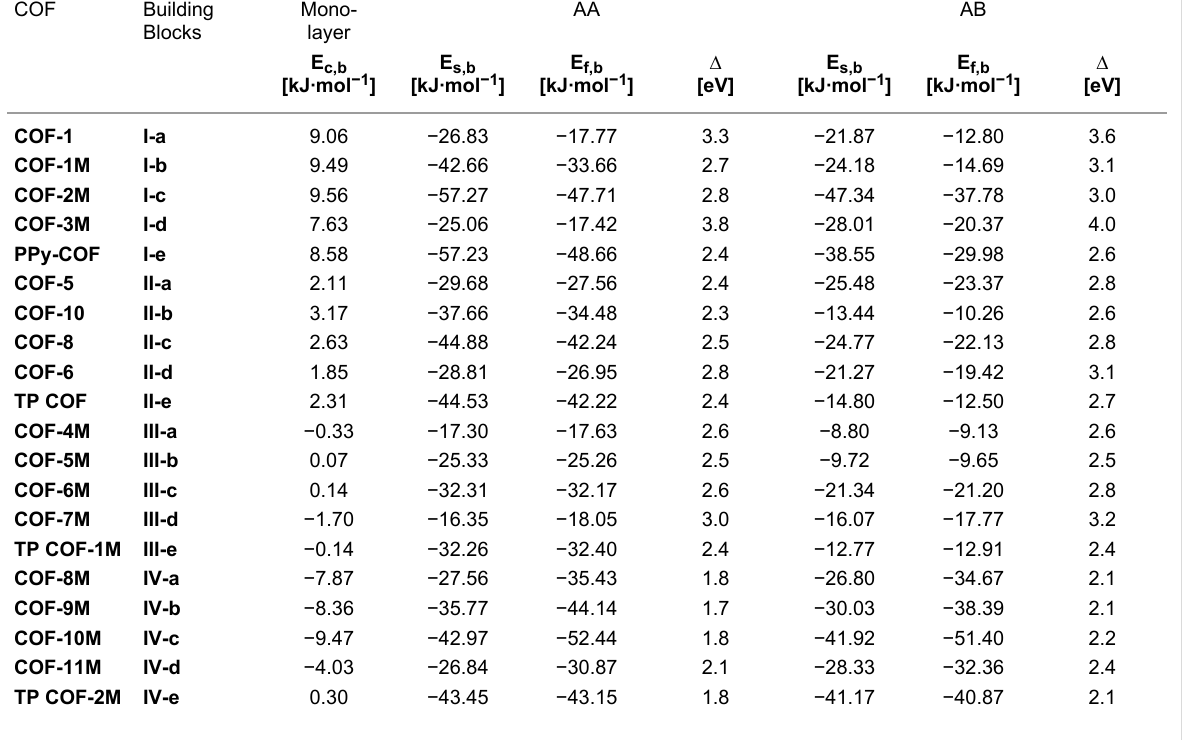
Table 2: The calculated energies [kJ•mol − 1 ] per bond formed between building blocks for AA and AB stacked COFs: E c,b is the condensation energy, E s,b is the stacking energy, and E f,b is the COF formation energy (E f,b = E c,b + E s,b ). The calculated band gaps, ∆ [eV], are given as well.